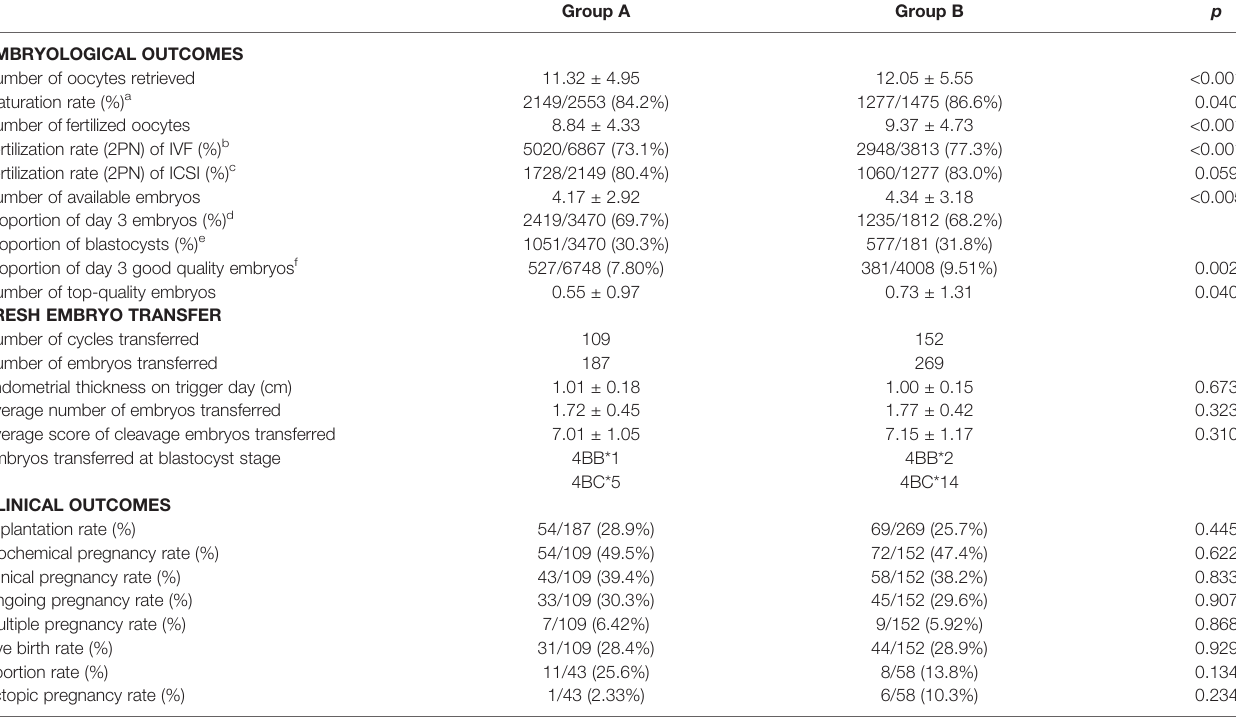
Group A Group B p